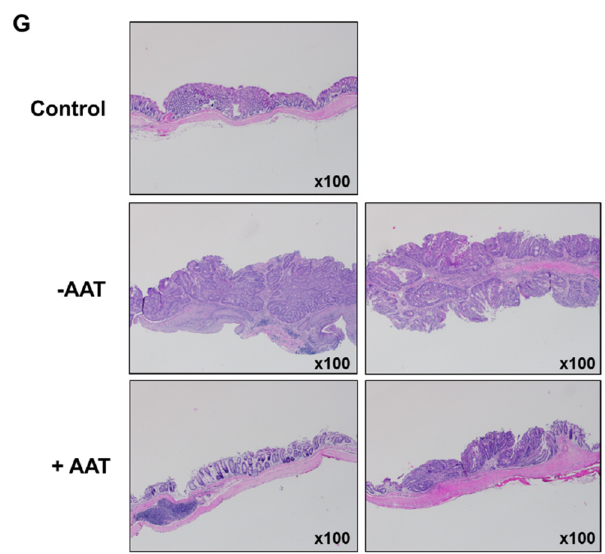
Figure 2. Therapeutic effects of AAT on established CAC. ( A ) Schematic overview of end-stage disease protocol for AAT administration in AOM/DSS-treated mice. Mice were injected with AOM (day 2 and day 65) followed by four cycles of 2.5% DSS in drinking water. AAT was administrated every 3 days after the last DSS cycle (day 77) for 18 days and tumors were examined on day 98. ( B ) left , A representative 18F-FDG PET/CT image of AOM/DSS-treated mice before (day 75) and after (day 98) AAT administration. Right , Gamma counting of entire colon was analyzed before and after treatment. The % change of FDG %ID/g of the before and after results between AOM/DSS-treated mice and AOM/DSS-treated mice with AAT administration was further analyzed. Results, mean ± SD [n = 3 ( − AAT), n = 5 (+AAT); *, p < 0.05. ( C ) Macroscopic changes in colon by AAT administration: Tumor multiplicity ( D ), tumor distribution ( E ), and average tumor load ( F ) were determined. Results, mean ± SD [n = 5 ( − AAT), n = 5 (+AAT); *, p < 0.05; **, p < 0.01]. ( G ) Colon tissue was fixed and stained with hematoxylin/eosin on day 98. Top, control colon tissue. AOM/DSS-treated colon tissue without (middle) and with (bottom) AAT administration. AOM/DSS and AAT-treated mice show reduced glandular hyperplasia, mixed inflammation and intramucosal adenocarcinoma formation, which is comparable to no AOM/DSS-treated control mice. Original magnification, ×10.